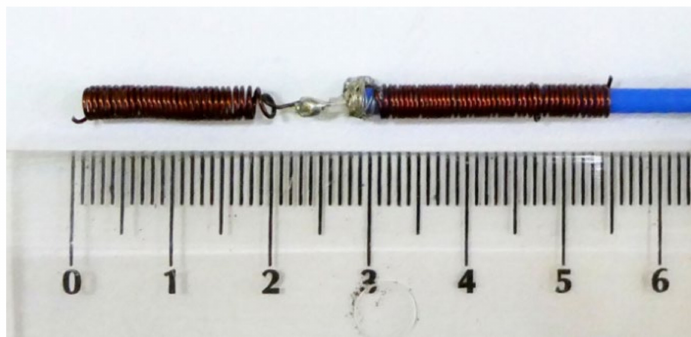
Figure 10. External receiver